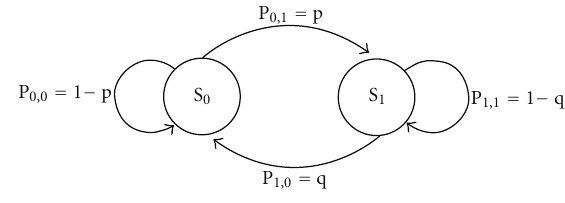
Figure 3: Gilbert channel